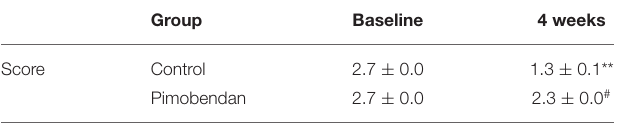
TABLE 4 | Histological scoring data of pancreas. Group